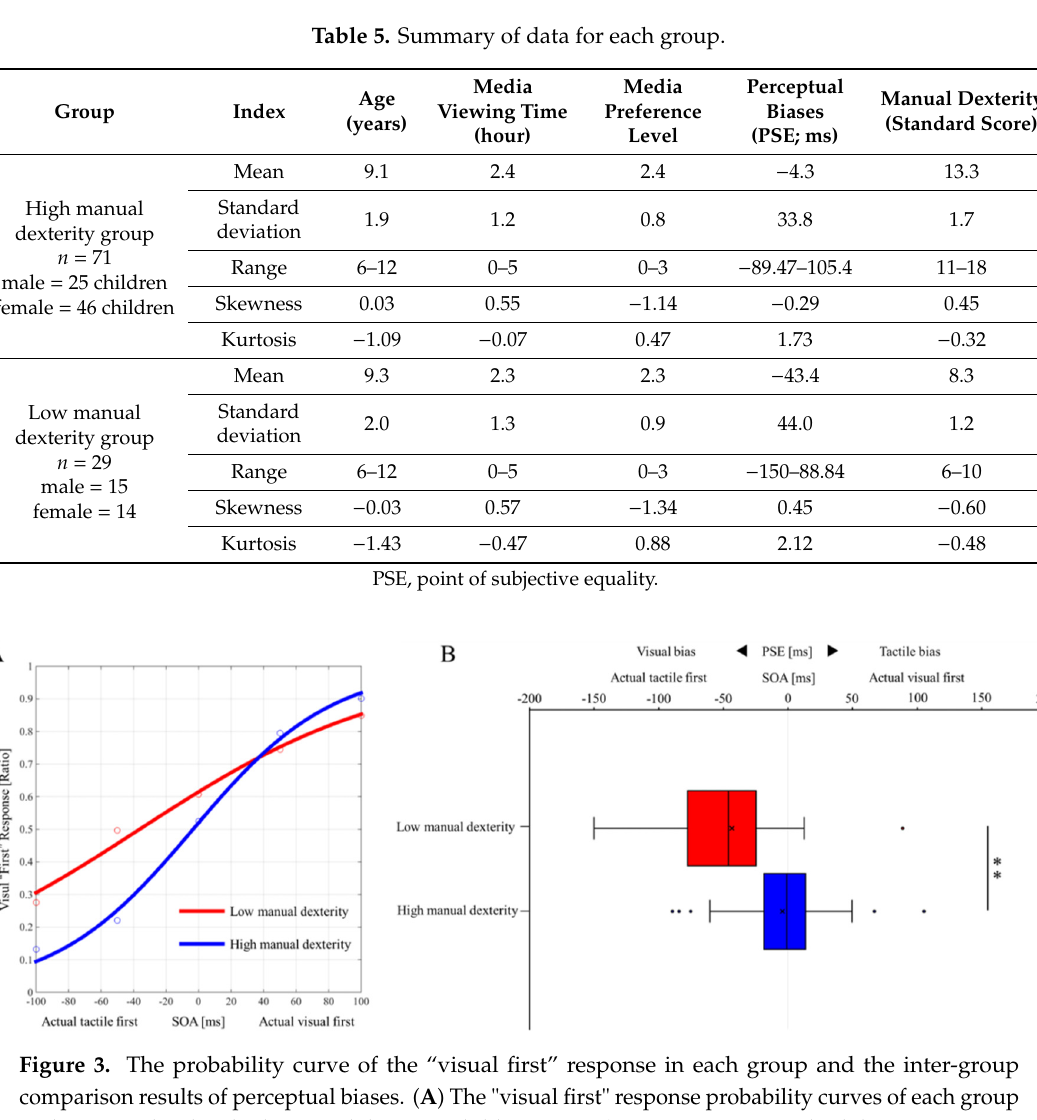
Table 5. Summary of data for each group.